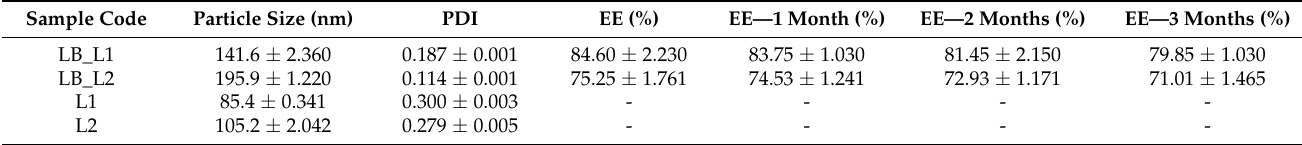
Table 1. Characteristics of liposomes loaded with L. barbarum . PDI, polydispersity index; EE, entrapment efficiency. Sample